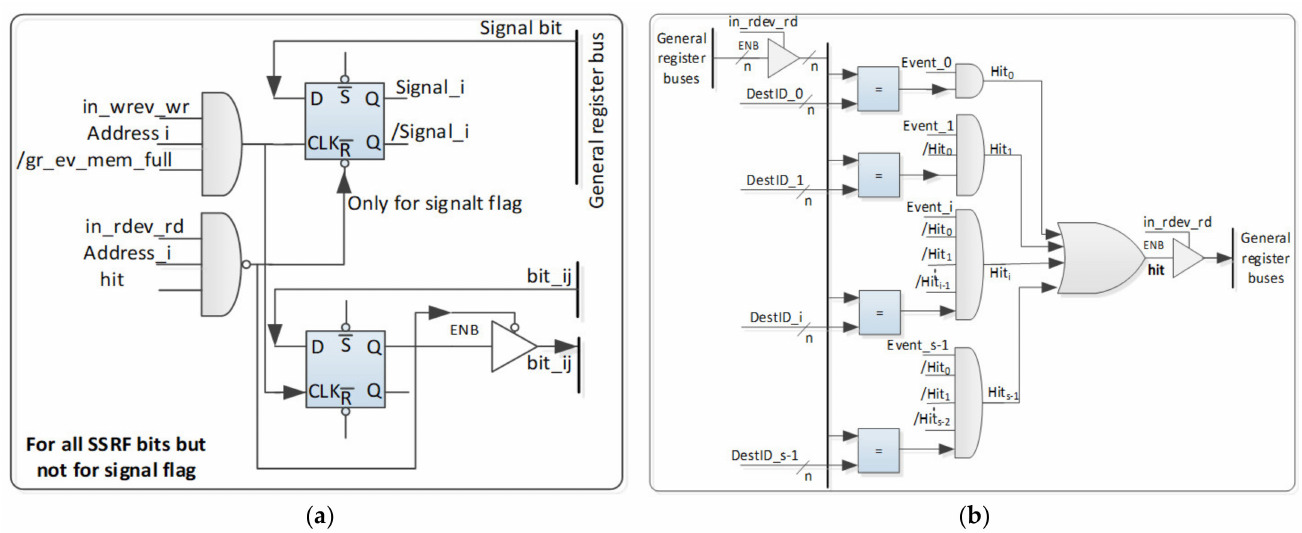
Figure 5. nHSE scheduler operation for real-time event handling: ( a ) read and write operations to SSRF registers; ( b ) content-addressable memory (CAM) read method of SSRi register and activation of the in_rdev_rd